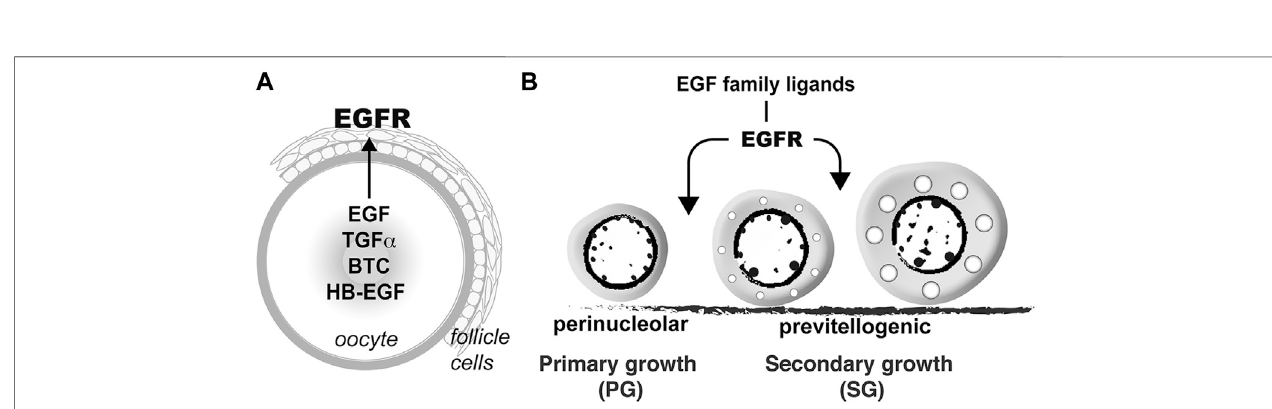
FIGURE 12 | Hypothetical model on roles of EGFR signaling in controlling folliculogenesis in zebra fi sh. (A) Intrafollicular distribution of EGF family ligands and their receptor EGFR (Egfra) in the follicle (Tse and Ge, 2010), suggesting an oocyte-to-follicle cell signaling pathway. (B) EGF ligands-EGFR signaling pathway plays an important role in controlling early follicle development in zebra fi sh especially follicle activation or PG-PV transition.